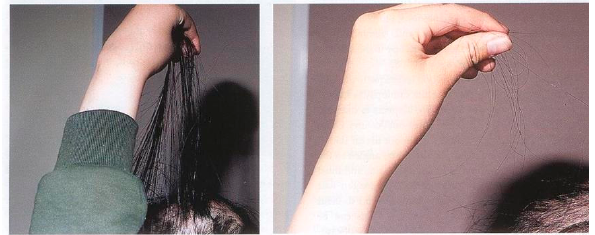
Figure 1. The hair pull test. Around 10 hairs are grasped firmly at the scalp between the thumb and index finger, and traction is applied as the hairs are pulled along their length. To measure hair shedding in women, a validated visual analogue scale has been developed. Hair shedding is scored on a scale of 1–6 (Figure 2). Women are asked to look at the scale and point